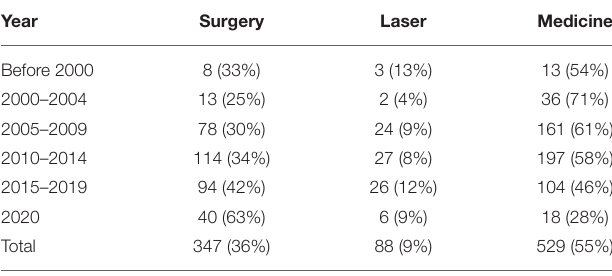
Year Surgery Laser Medicine Year IOP lowering